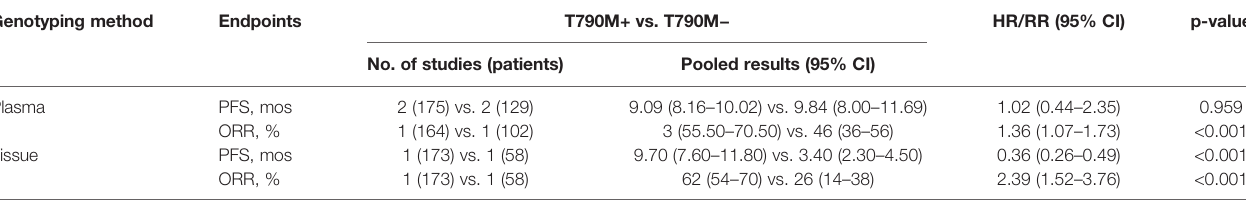
TABLE 3 | Pooled results of survival and response rate the T790M-positive and T790M-negative groups with different genotyping samples. Genotyping method